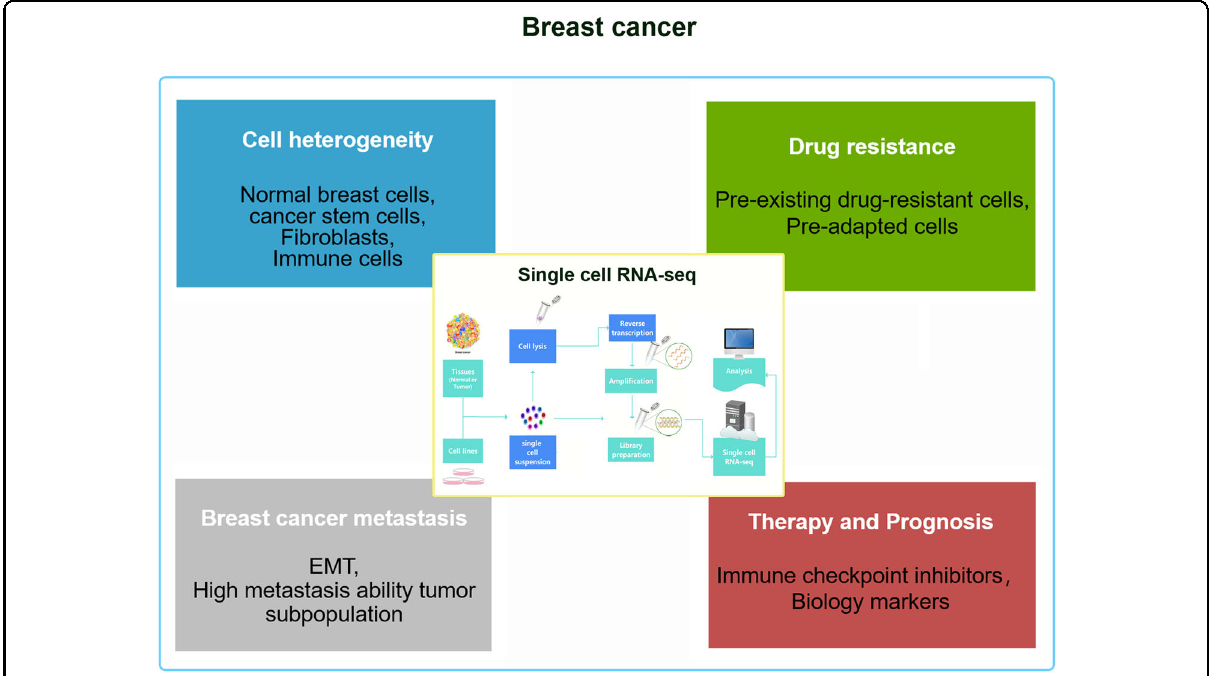
Fig. 3 Recapitulation of the contents of the review. Summary of the current application of the scRNA-seq technology in the cell heterogeneity, metastasis, drug resistance, immunotherapy, and prognosis of breast